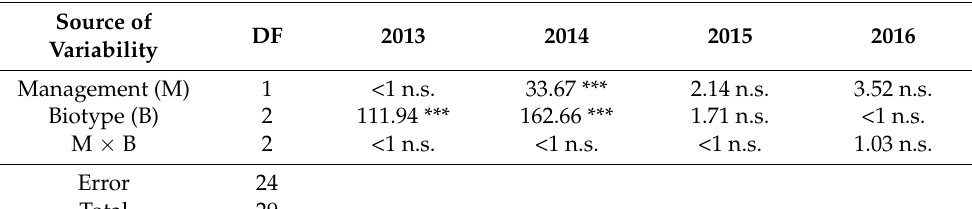
Table 1. Results of ANOVA ( F values) for the height of plants at flowering time of 3 H. perforatum biotypes cultivated from 2014 to 2016 in open field and in